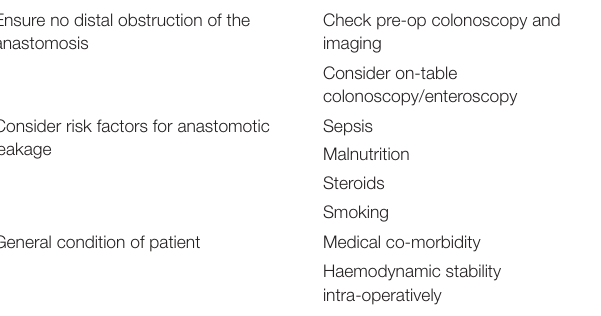
TABLE 3 | Factors to consider prior to intestinal anastomosis in Crohn’s disease. Ensure no distal obstruction of the anastomosis